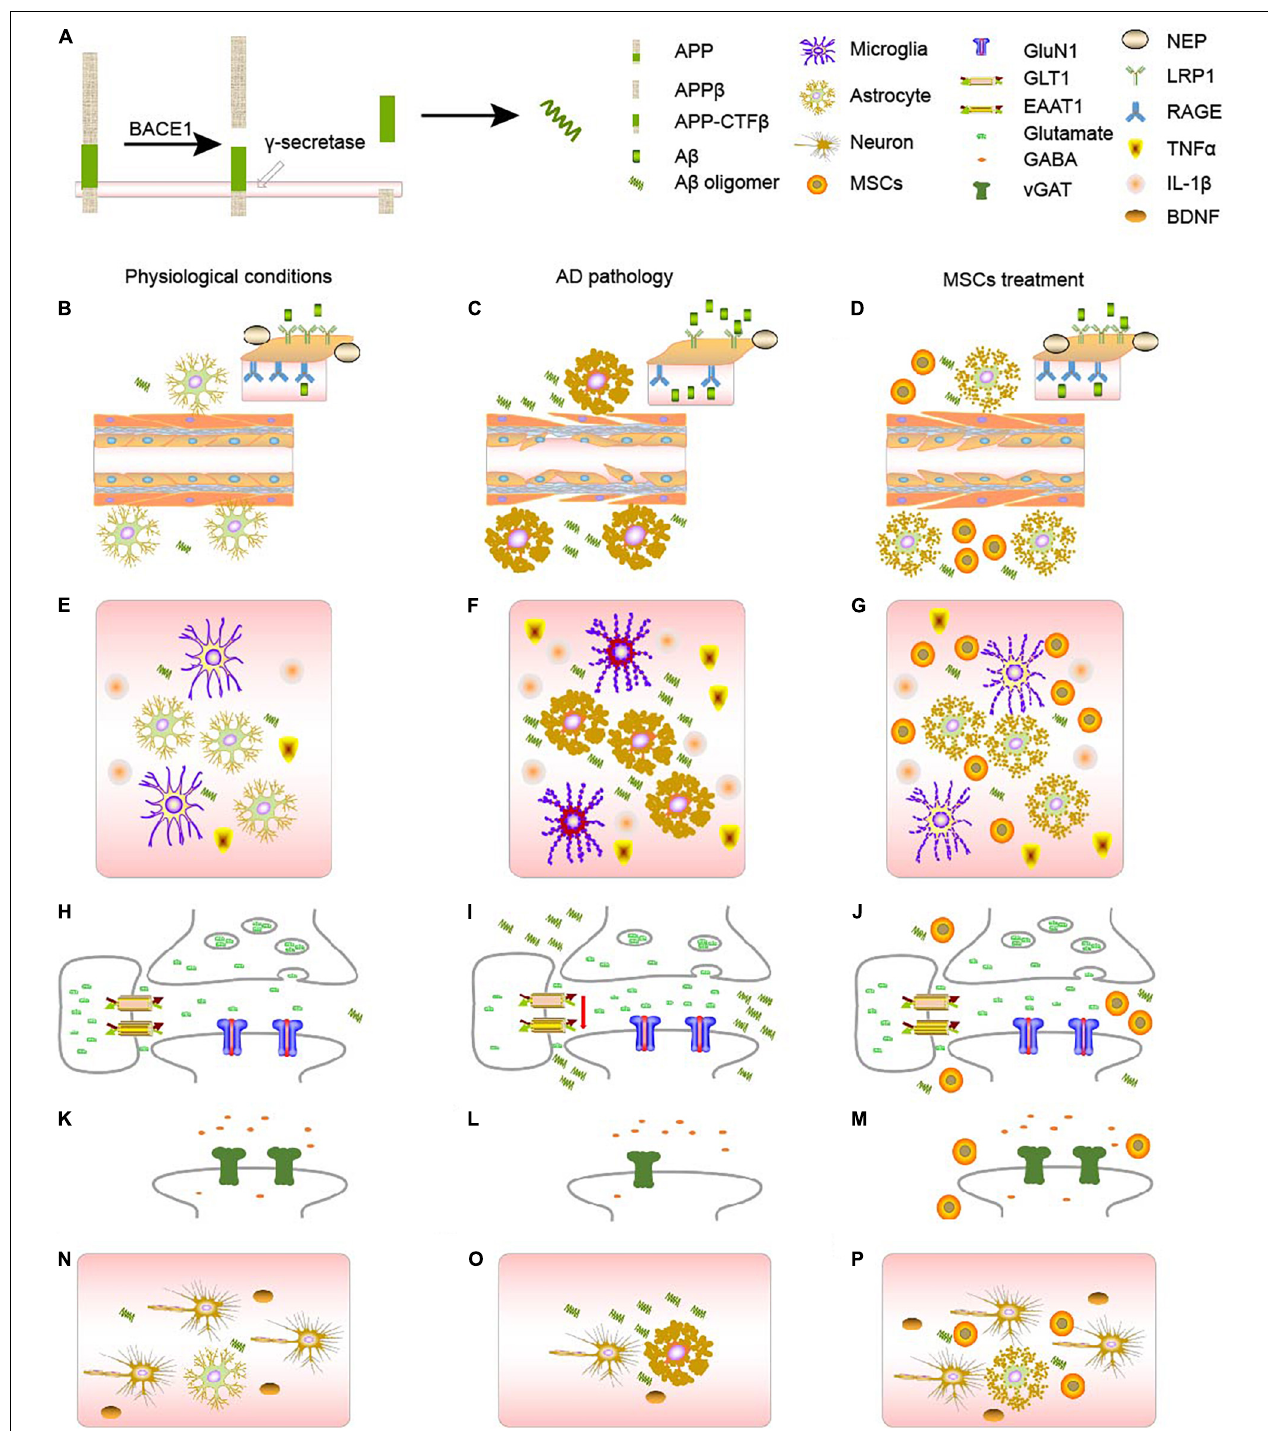
FIGURE 1 | AD pathology and MSCs treatment. (A) The generation of A β from APP. (B–D) Changes of AD metabolism. (B) In physiological conditions, APP will gradually be decomposed by BACE1 and γ -secretase. RAGE and LRPs, together with NEP on the blood brain barriers will balance the concentration of A β in the body. (C) In AD context, astrocytes will become reactive astrocytes, which will disturb the BBB, decreasing the number of RAGE, LRPs, and NEP, and eventually causing the accumulation of A β , forming a vicious circle. (D) MSCs treatment can turn reactive astrocytes into normal astrocytes, ameliorate the damage of blood vessels, and therefore cure the disease to some extent. (E–G) Changes of neuroinflammation. (E) In physiological conditions, both astrocytes and microglia will secrete proper amount of inflammatory factors such as TNF- α and IL-1 β , maintain the homeostasis in the body. (F) In AD context, either astrocytes or microglia